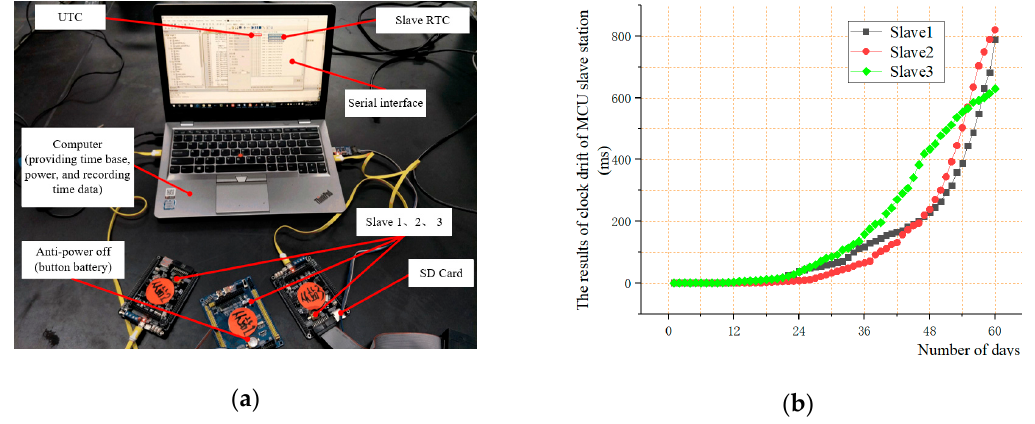
Figure 6. ( a ) The test of clock drift of slave station; ( b ) The results of clock drift of slave station.